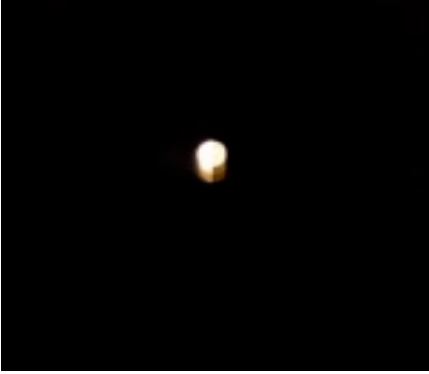
Figure 10. White light generated from the In 0.1 Ga 0.9 N LED.